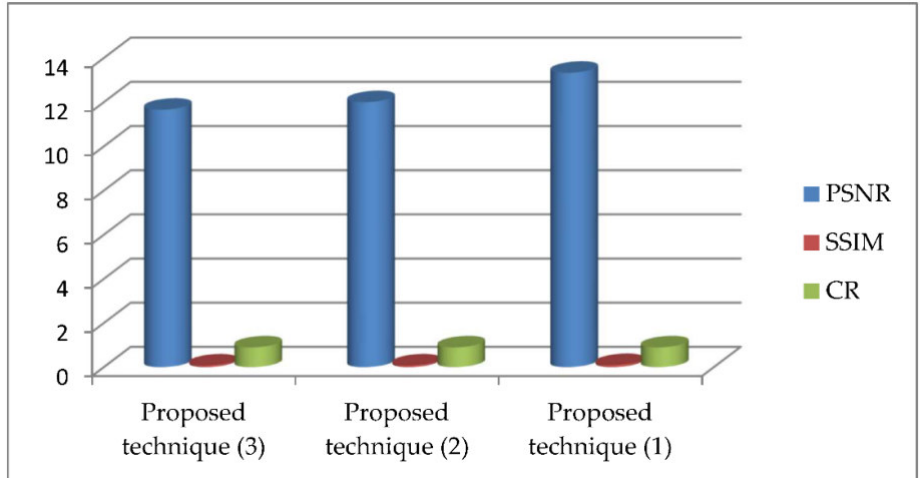
Figure 7. Comparison of PSNR, SSIM and Cr for color airplane image for the three proposed techniques using chaotic encryption.